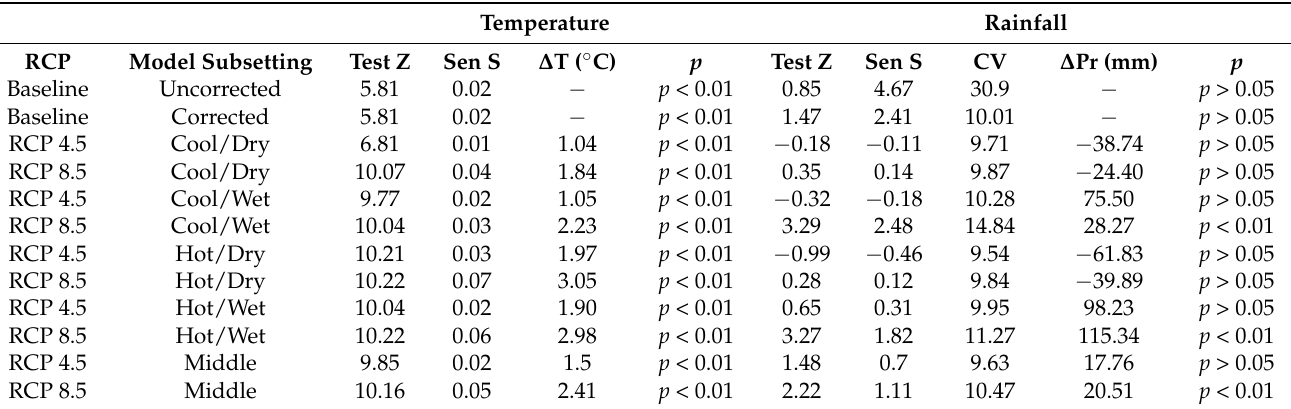
Table 4. Change in trends of temperature and rainfall data from the reference period and projected data trends under RCP 4.5 and RCP 8.5.